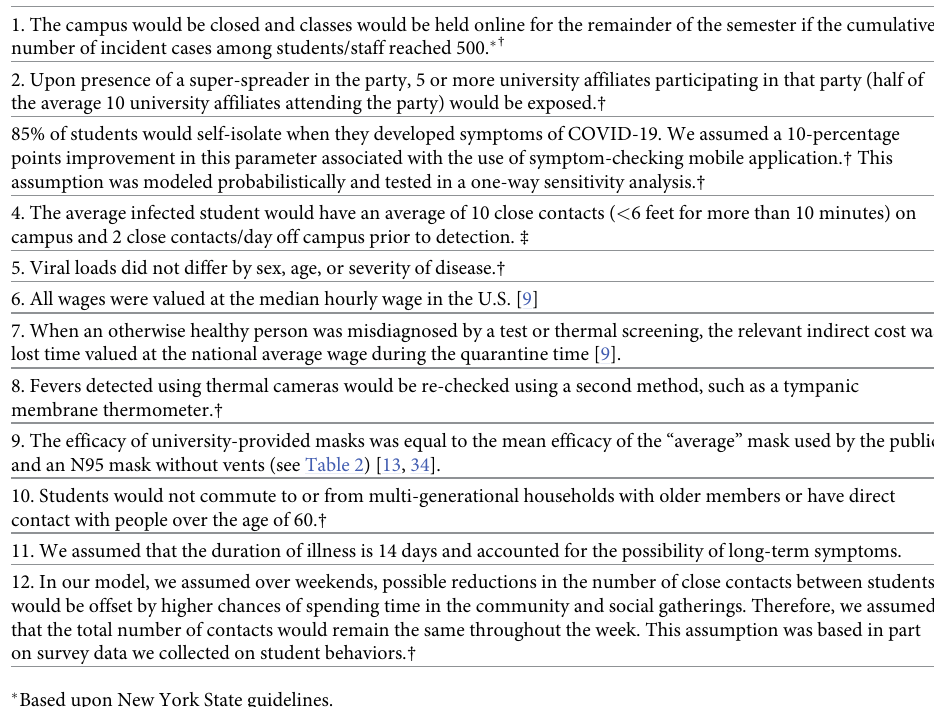
Table 1. Major assumptions used in modeling the cost-effectiveness of strategies to improve infection control for COVID-19 in the university